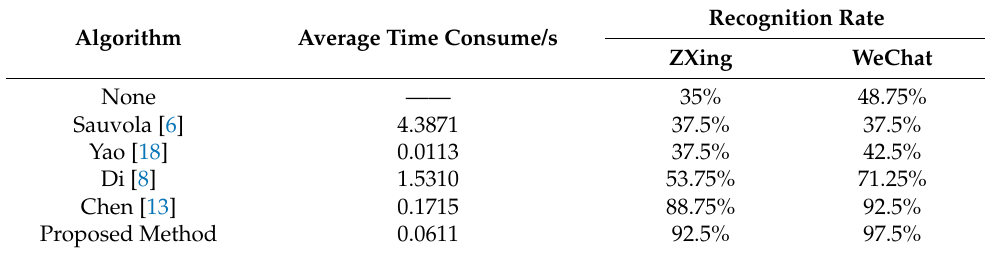
Table 5. Recognition rates after processed by different